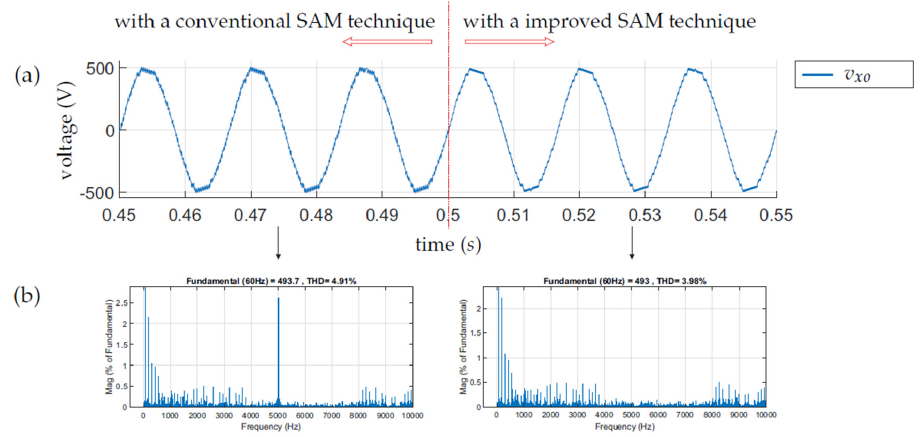
Figure 14 Figure 14. ( a ) the phase voltage levels; ( b ) the phase voltage harmonics detail. Figure 14. (a) the phase voltage levels; (b) the phase voltage harmonics detail.